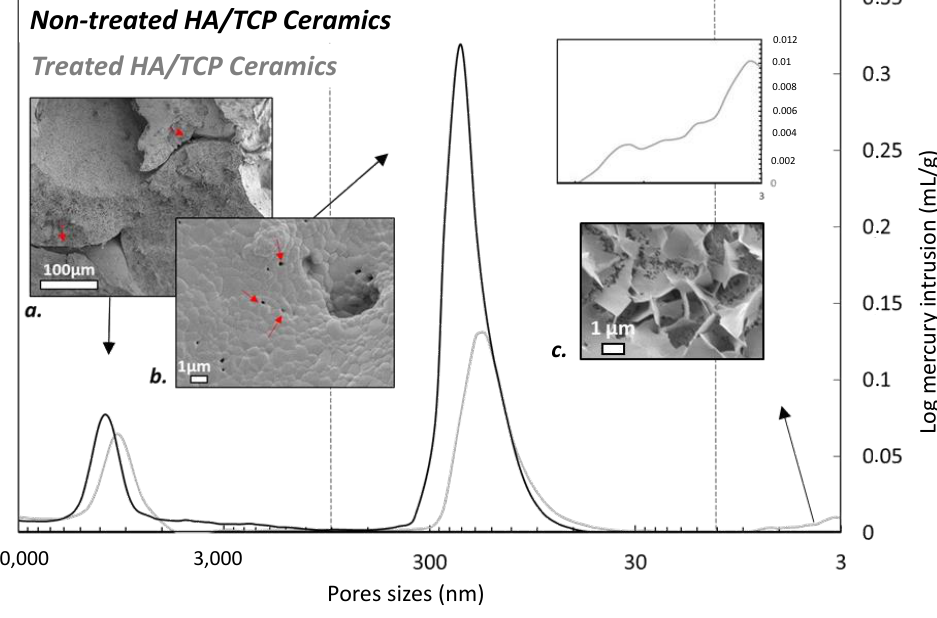
Figure 4. Mercury intrusion porograms of untreated ( a , b ) and CO 2 -treated ( c ) BCP ceramic scaffold and related SEM micrographs. Red arrows point to sintering defects in the BCP initial structure.